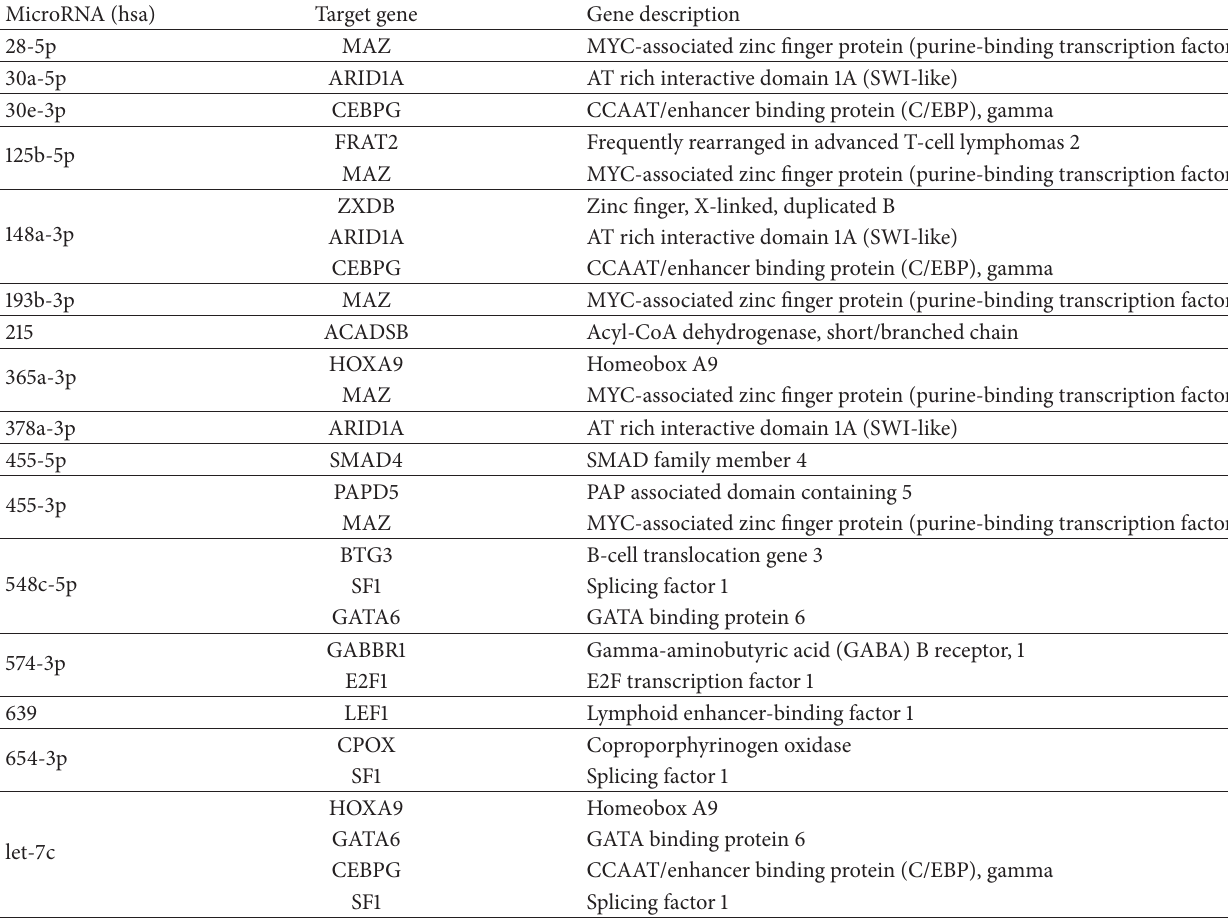
Table 2: Liver-specific target genes with CLIP-seq overlap for 16